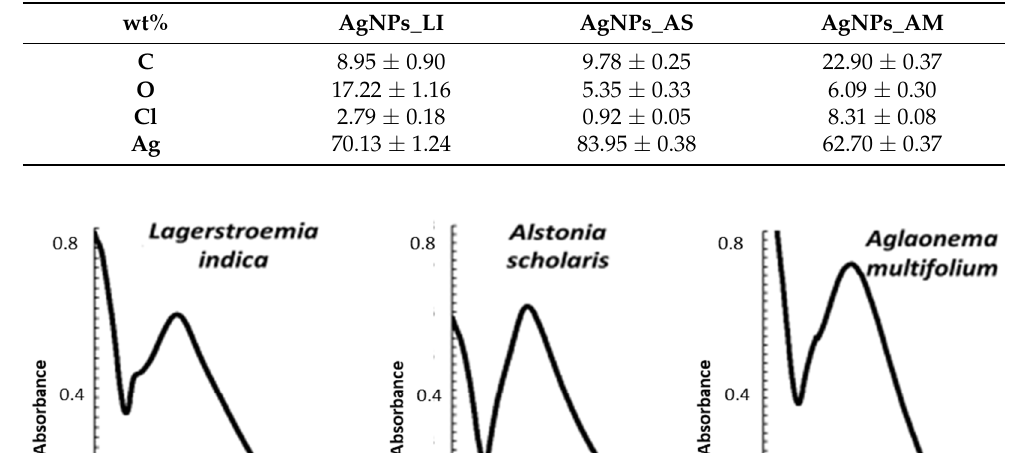
Table 1. Energy-dispersive X-ray spectroscopy (EDX) analysis of AgNPs from L. indica (LI), A. scholaris (AS), A. multifolium (AM). All measurements were performed in no less than five repli- cates.